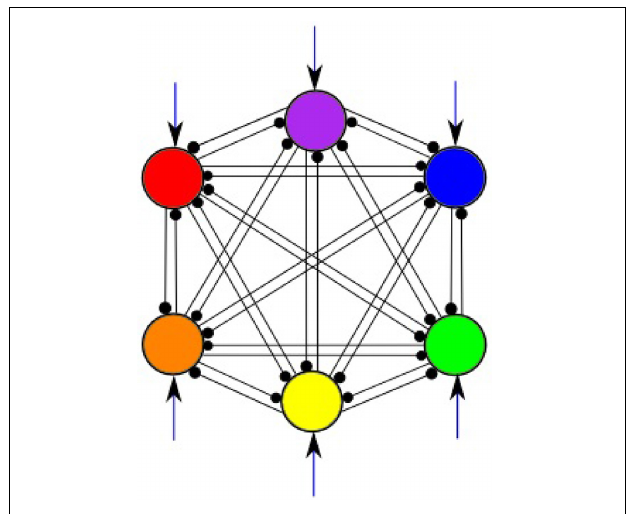
FIGURE 2 | All-to-all inhibitory interactions between 6 modes (information items) of the cognitive network; excitatory self connections are not shown. Black arrows represent incoming signals.